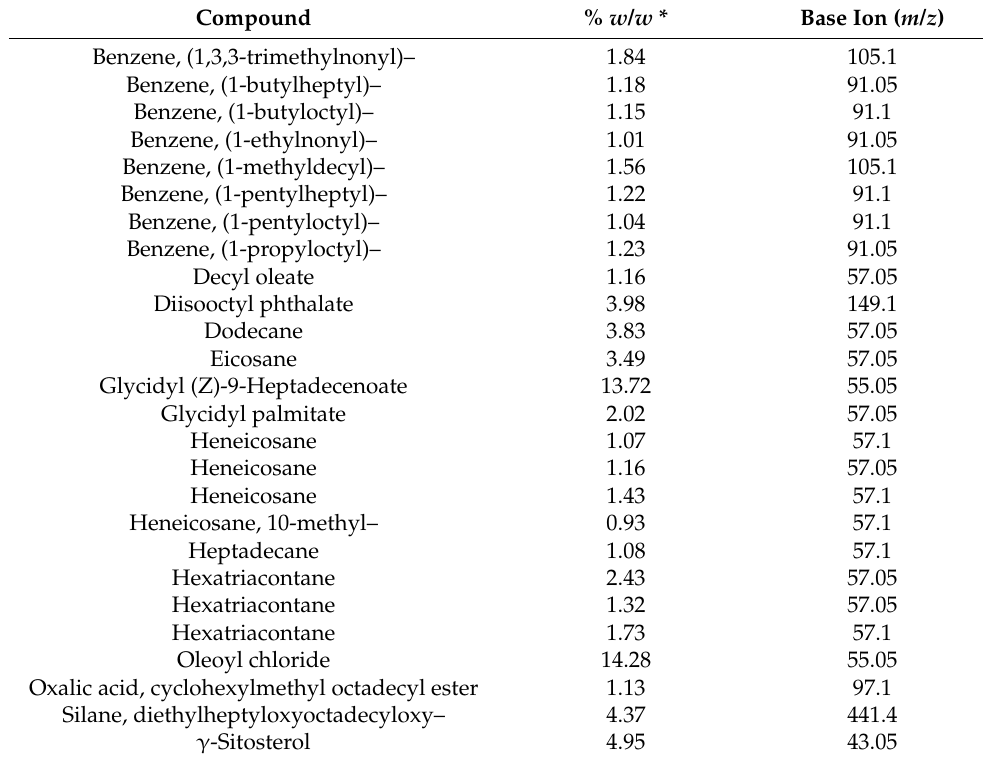
Table 2. Compounds determined in unsaponifiable matter of the working hemp seed oil